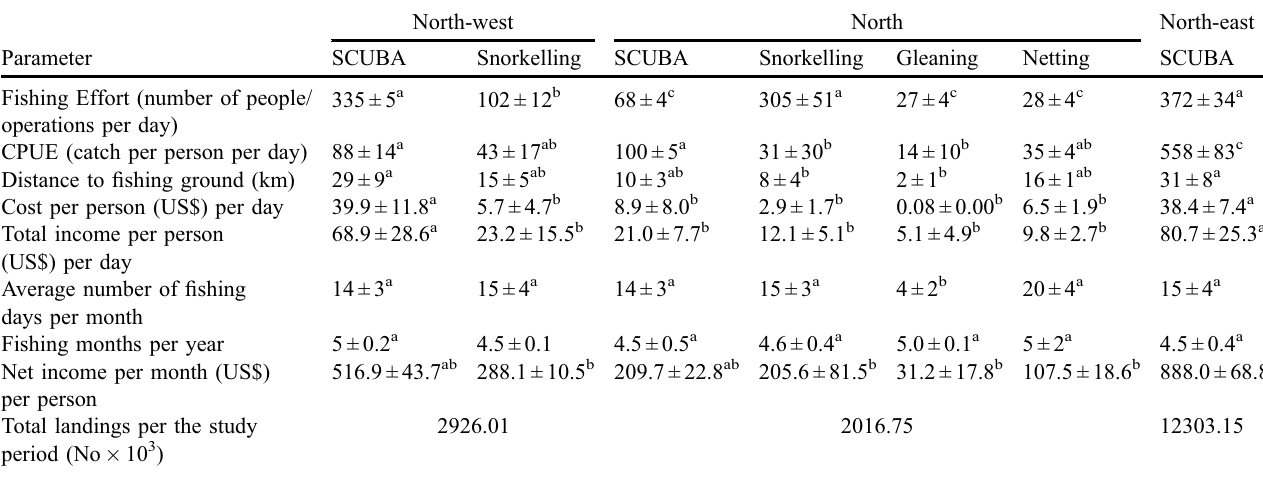
Note: Fishing effort is a measure of the number of divers per region for SCUBA, snorkelling and gleaning methods and the number of surrounding nets in netting method. Values in same raw bearing, different letters are signi fi cantly different (ANOVA, p <